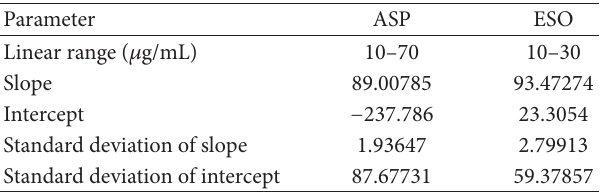
T 2: Calibration data for ASP and